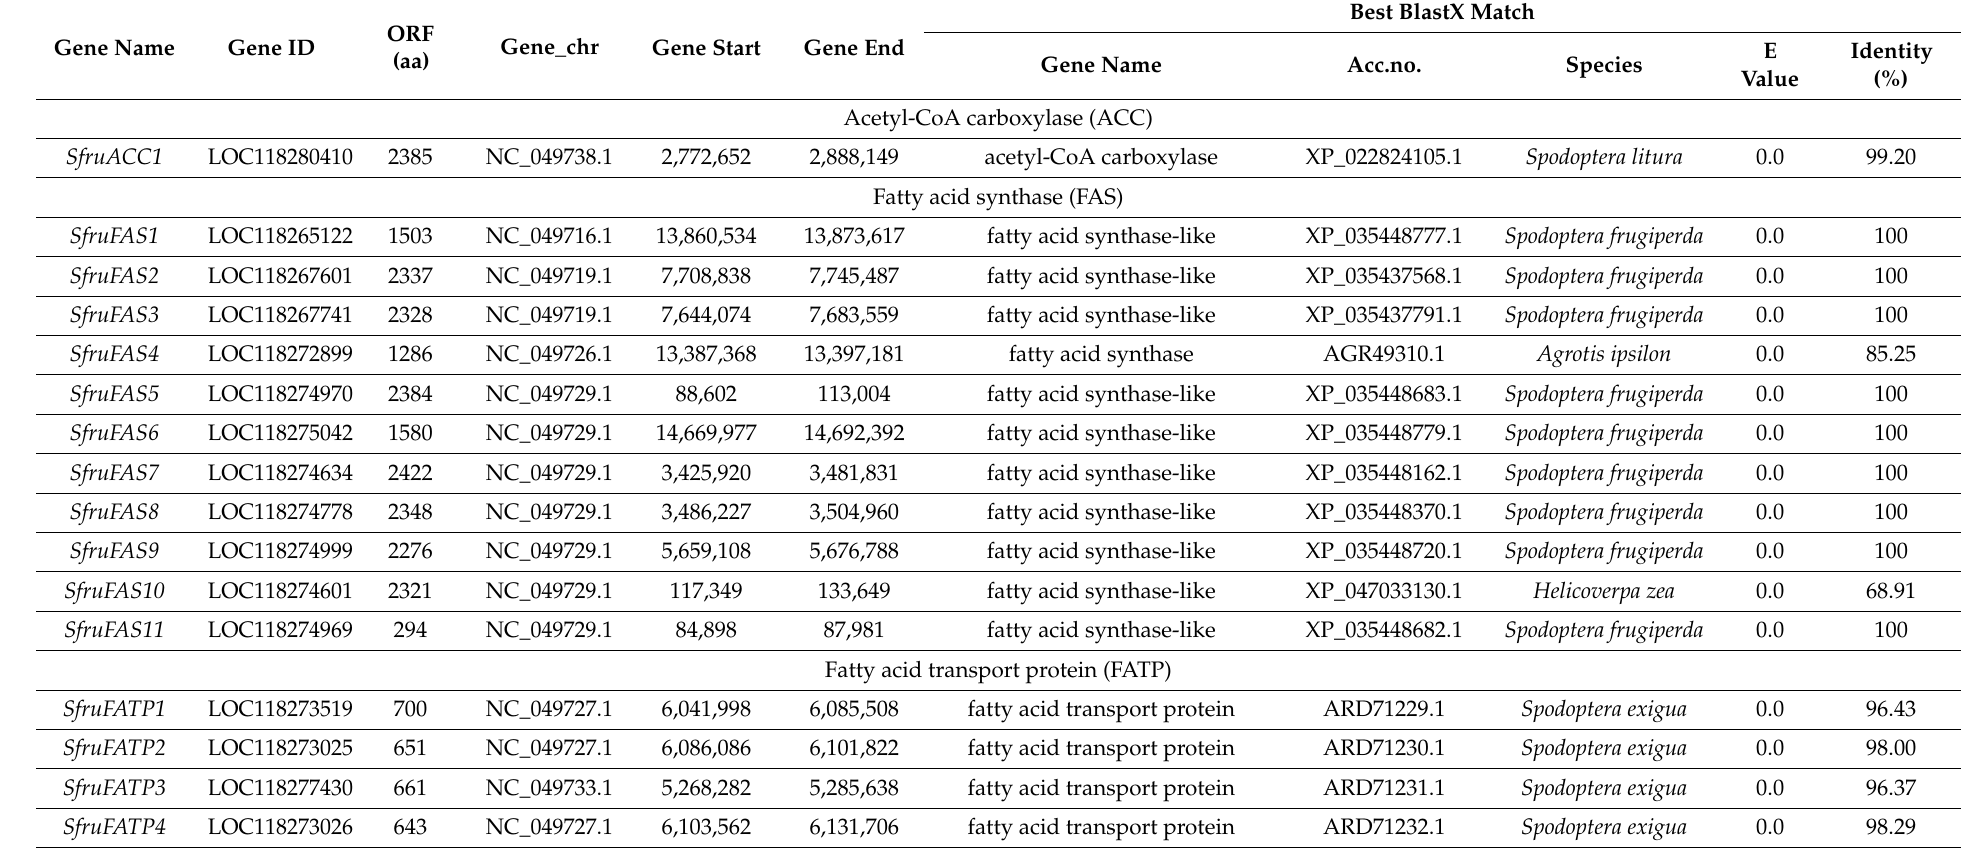
Table 1. Genes related to sex pheromone biosynthesis in Spodoptera frugiperda